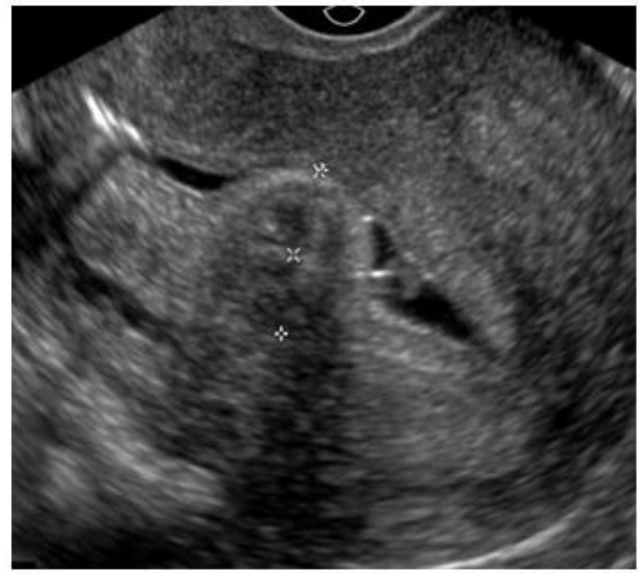
Figure 2. Submucous myoma on ultrasound. * Submucosal fibroid. Hysterosonography, an ultrasound procedure performed with the uterus distended with saline solution for greater contrast and detailing of the uterine cavity, is more accurate than TVUS in identifying the uterine cavity and myometrial mantle (Figure 3).